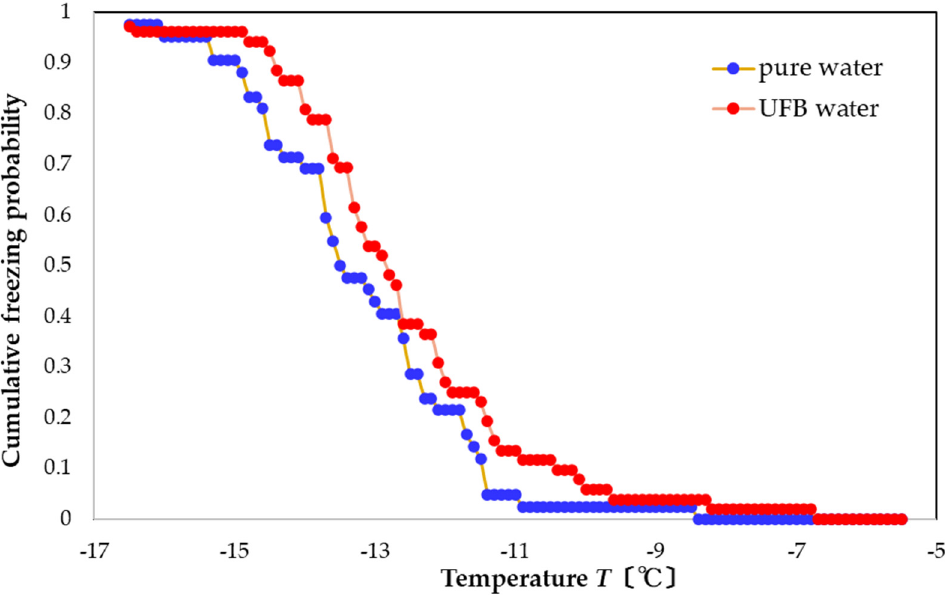
Figure 2. Freezing curves of pure water and UFB water, one day after